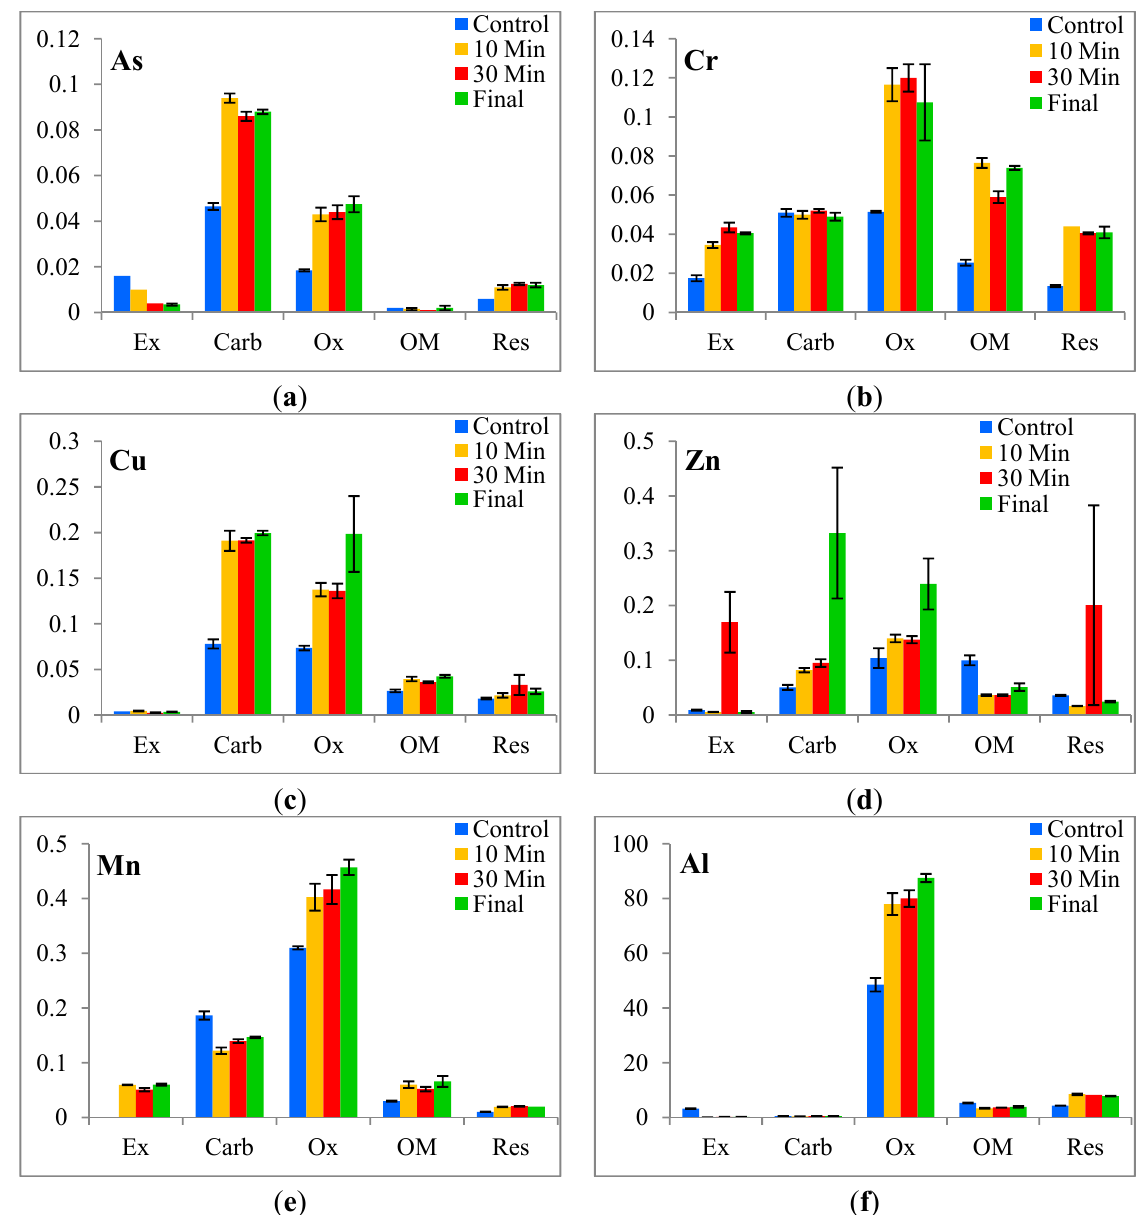
Figure 3. Sequential chemical fractionation concentrations (mg/L) for the selected trace elements: ( a ) arsenic; ( b ) chromium; ( c ) copper; ( d ) zinc; ( e ) manganese; ( f ) aluminum Fractions: Ex = exchangeable; Carb = carbonate; Ox = oxide; OM = organic matter; Res =